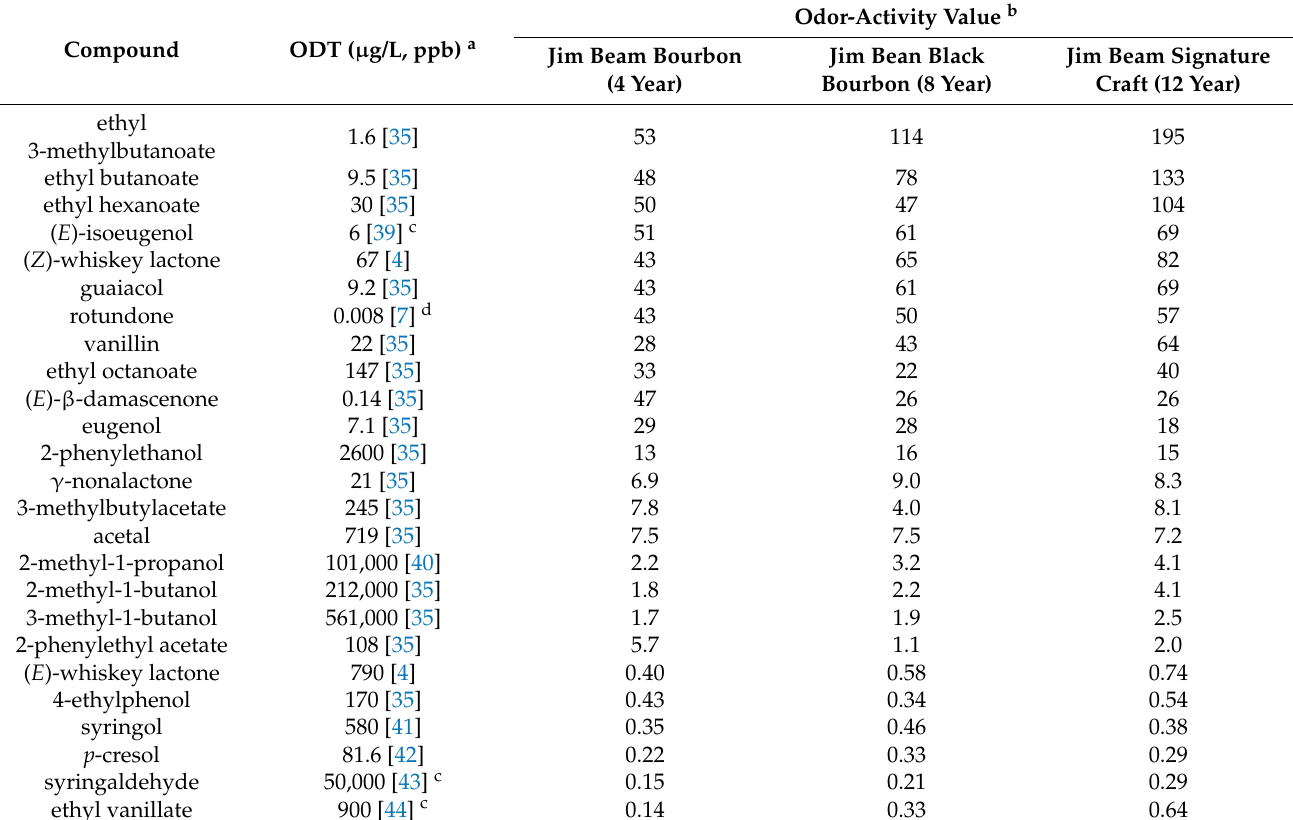
Table 5. Odor-activity values for selected odorants in bourbon whiskeys aged for 4, 8, and 12 years.